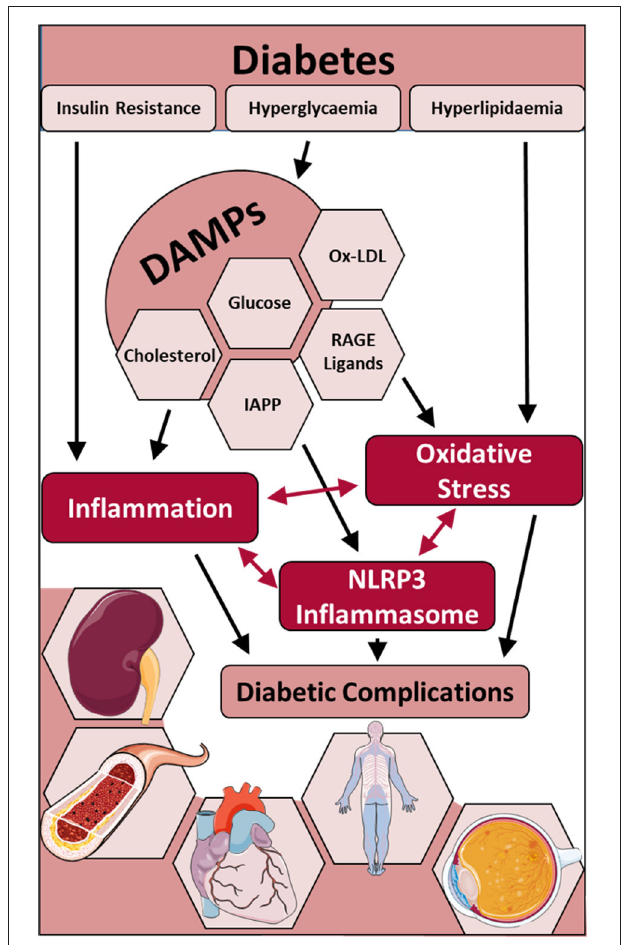
FIGURE 1 | The role of the NLRP3 inflammasome and interconnectivity with oxidative stress and inflammation in the development of complications in diabetes. Metabolic changes in diabetes including insulin resistance, hyperlipidaemia and hyperglycaemia (and the subsequent production of DAMPs), lead to an increase in inflammation, oxidative stress and NLRP3 inflammasome activation and subsequent development of diabetic complications including diabetic nephropathy, atherosclerosis, diabetic cardiomyopathy, diabetic neuropathy and diabetic retinopathy. DAMPs, damage associated molecular patterns; RAGE, receptor for advanced glycation end-products; IAPP, islet amyloid polypeptide